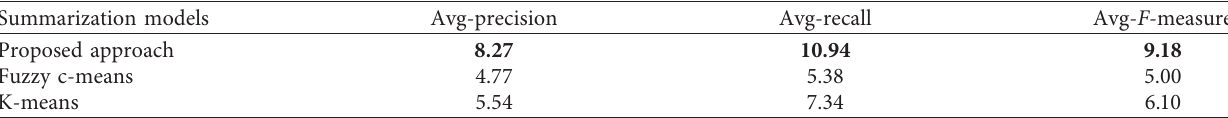
Table 4: Evaluation of summarization models on various measures using ROUGE - 2 on NYC